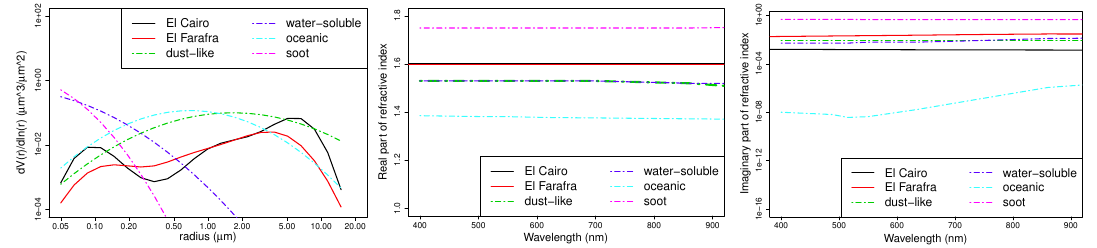
Figure 2. The microphysical properties of the aerosol available from AERONET stations in Cairo and El Farafra measured close in time to the Landsat overpass (Table 2) and the microphysical properties of the aerosol basic components reported in [25]. On the left, the volumetric size distribution; in the center, the real part of the refractive index; on the right, the imaginary part of the refractive index.